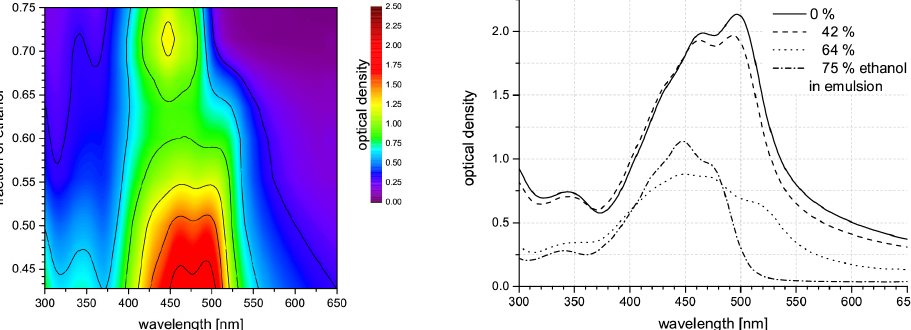
Figure 10. Absorption spectra of β -carotene emulsion depending on the ratio of ethanol and water. Spectra were scaled to the same β -carotene concentration assuming linear dependence of optical density on the concentration. The spectral map ( left ) quasi-continuously shows the transformation of the absorption characteristics of β -carotene emulsion in aqueous solution from 42% ethanol to 75% ethanol content. Three spectra from characteristic points of this series of measurements and an additional spectrum of β -carotene emulsion in pure water (from a different stock solution) are compiled in the graph on the right (reproduced with permission from